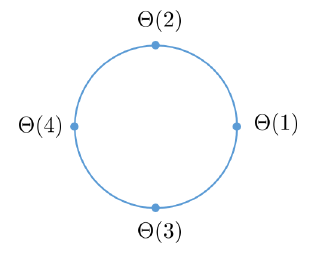
Figure 6. The Θ( i ) on the